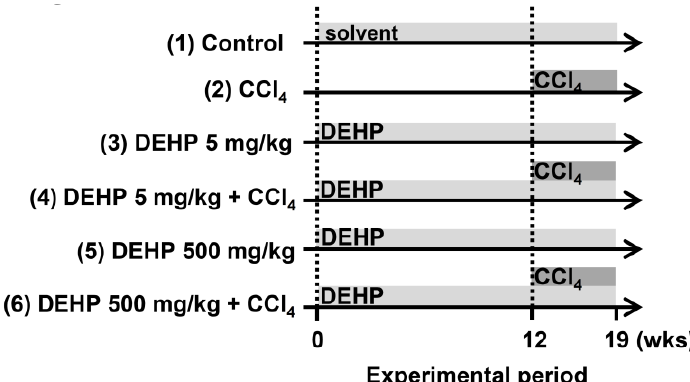
Figure 1. Experimental design for carbon tetrachloride (CCl 4 )-induced liver fibrosis in long-term, low-dose, di-(2-ethylhexyl) phthalate (DEHP)-exposed mice.